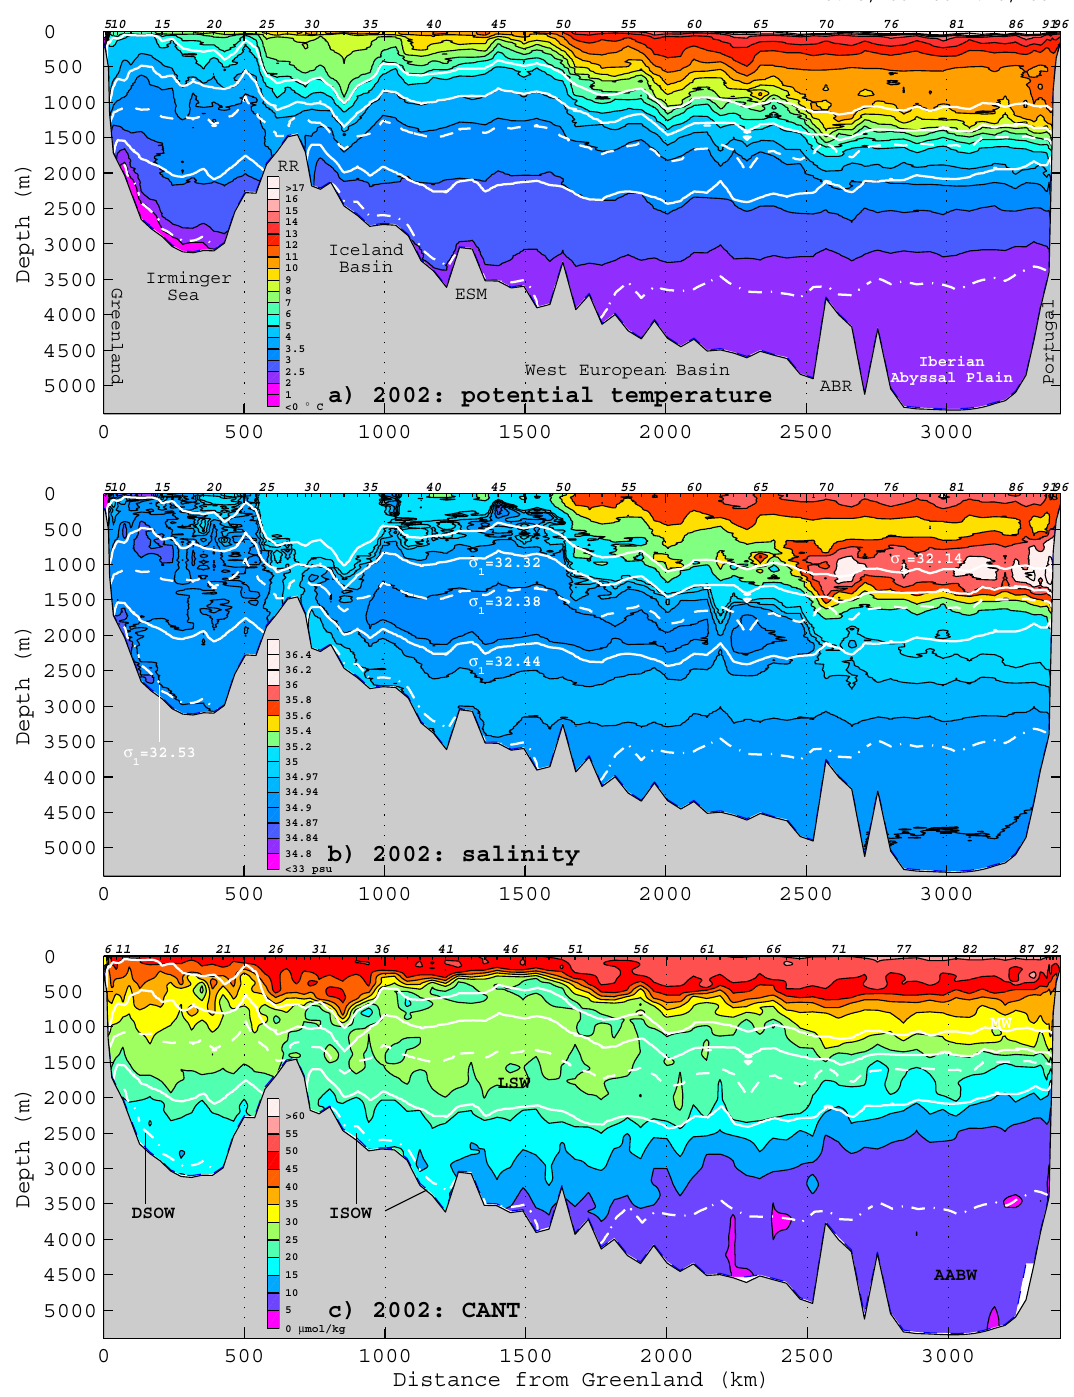
Fig. 2. OVIDE sections of 2002 and 2010 of (a, d) potential temperature in ◦ C, (b, e) salinity and (c, f) anthropogenic CO 2 in µmolkg − 1 . The depth of the isopycnals referenced in the manuscript are plotted in all the figures; their specific values are indicated in (b) and (e) . All the water masses cited in the manuscript are localized in the section in (c) and (f) : DSOW=Demark Strait Overflow Water, ISOW=Iceland Scotland Overflow Water, LSW=Labrador Sea Water, MW=Mediterranean Water, AABW=Antarctic Bottom Water. The other abbreviations in (a) and (d) are RR=Reykjanes Ridge, ESM=Eriador Sea Mount and ABR=Azores–Biscay Ridge. The numbers at the top of each plot indicate the station numbers corresponding to each